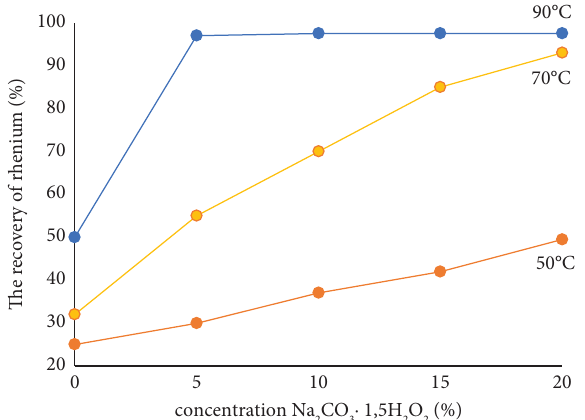
Figure 3: Infuence of sodium peroxocarbonate concentration and temperature on the degree of rhenium extraction into solution ( S : L � 1 :3, process duration: 30 minutes, and stirring speed: 200rpm).